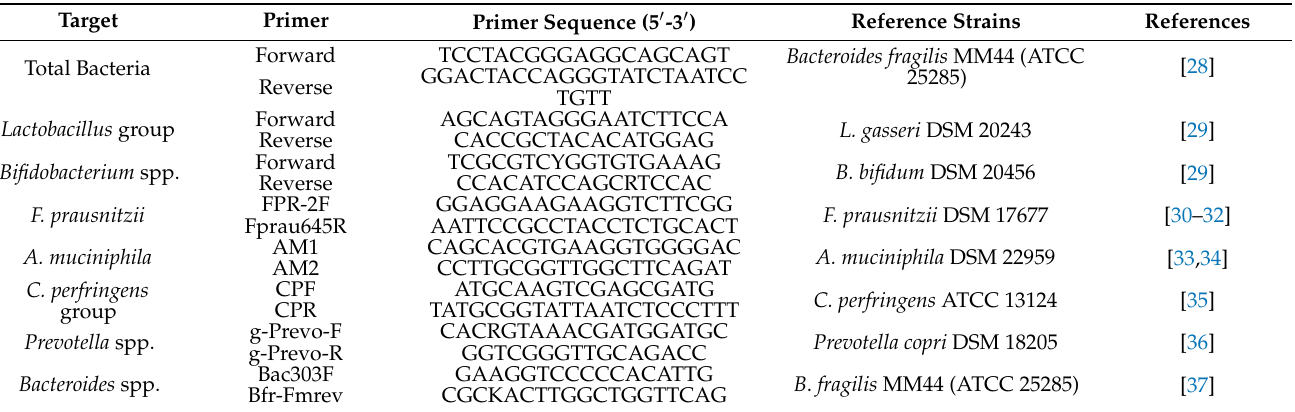
Table 2. Species-, genus-, and group-specific primers targeting the 16S rRNA and qPCR characteristics of gut microbiota